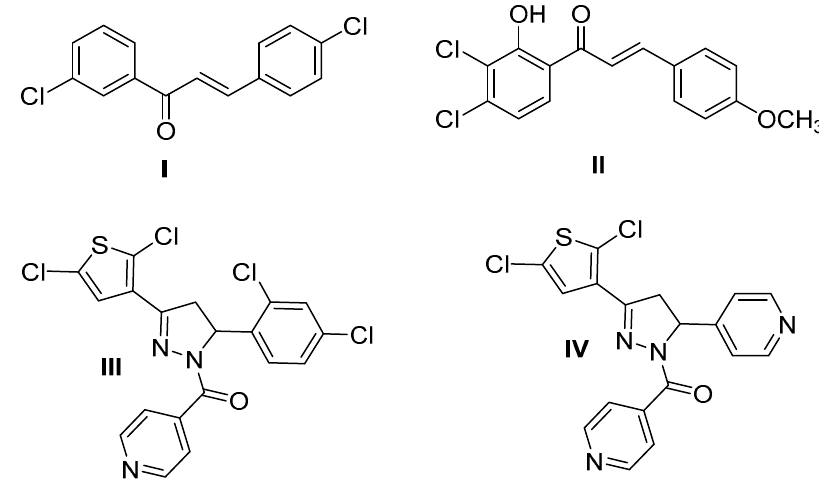
Figure 1. Structures of chlorinated and heteroaryl-based chalcones and dihydropyrazoles with potential biological activities.